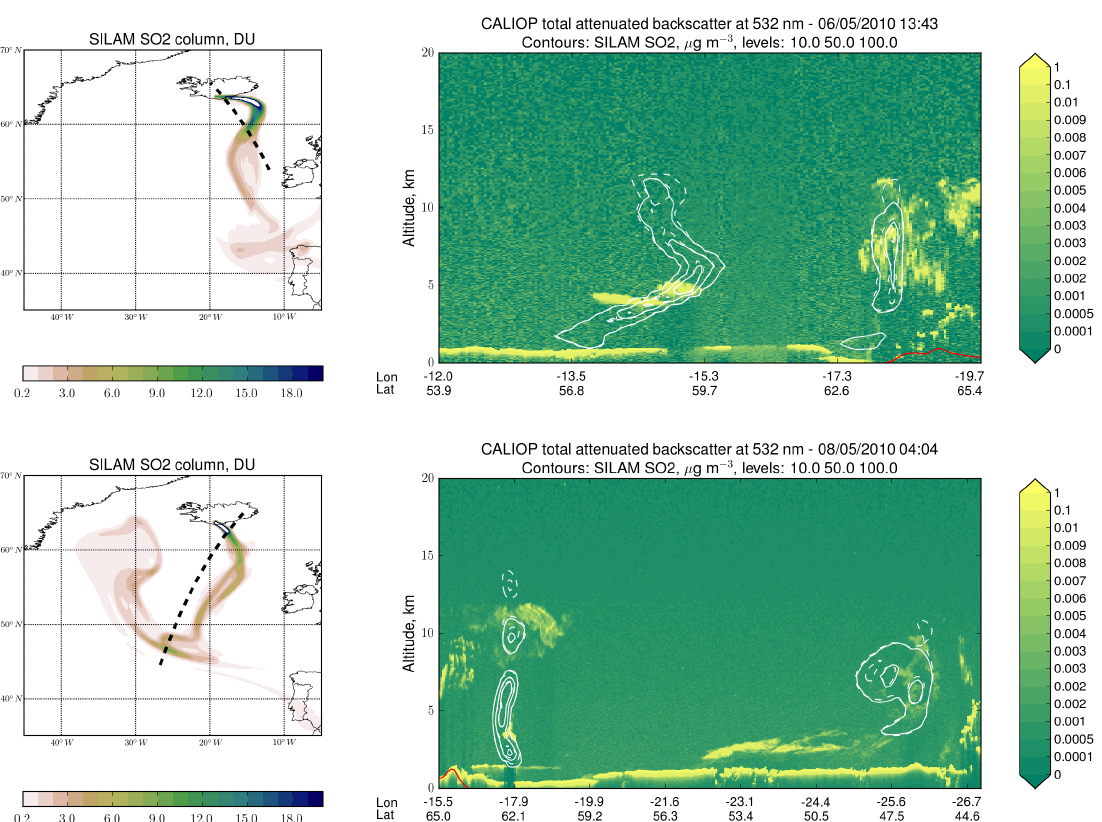
Figure 11. Comparison of simulated SO 2 with CALIOP data for 14:00UTC on 6 May (top) and 04:00UTC on 8 May 2010 (bottom). Left: the simulated SO 2 total column (DU, with assimilation of both total column and plume height) with the CALIPSO track plotted with dashed line. Right: CALIOP total attenuated backscatter at 532 nm with the simulated SO 2 concentration represented by contours. The solid contours correspond to assimilation of both total column and plume height; the dashed contours correspond to assimilation of total column only. The contour levels are 10, 50 and 100µgm − 3